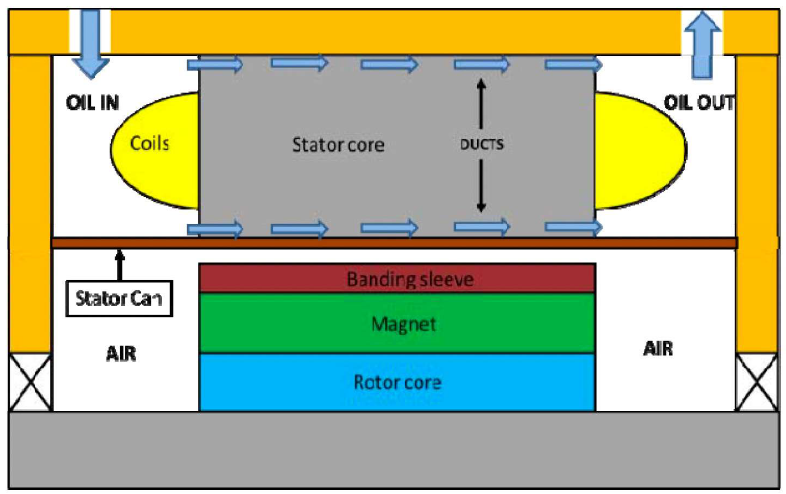
Figure 16. Schematic of a semi-flooded oil cooling system [40].